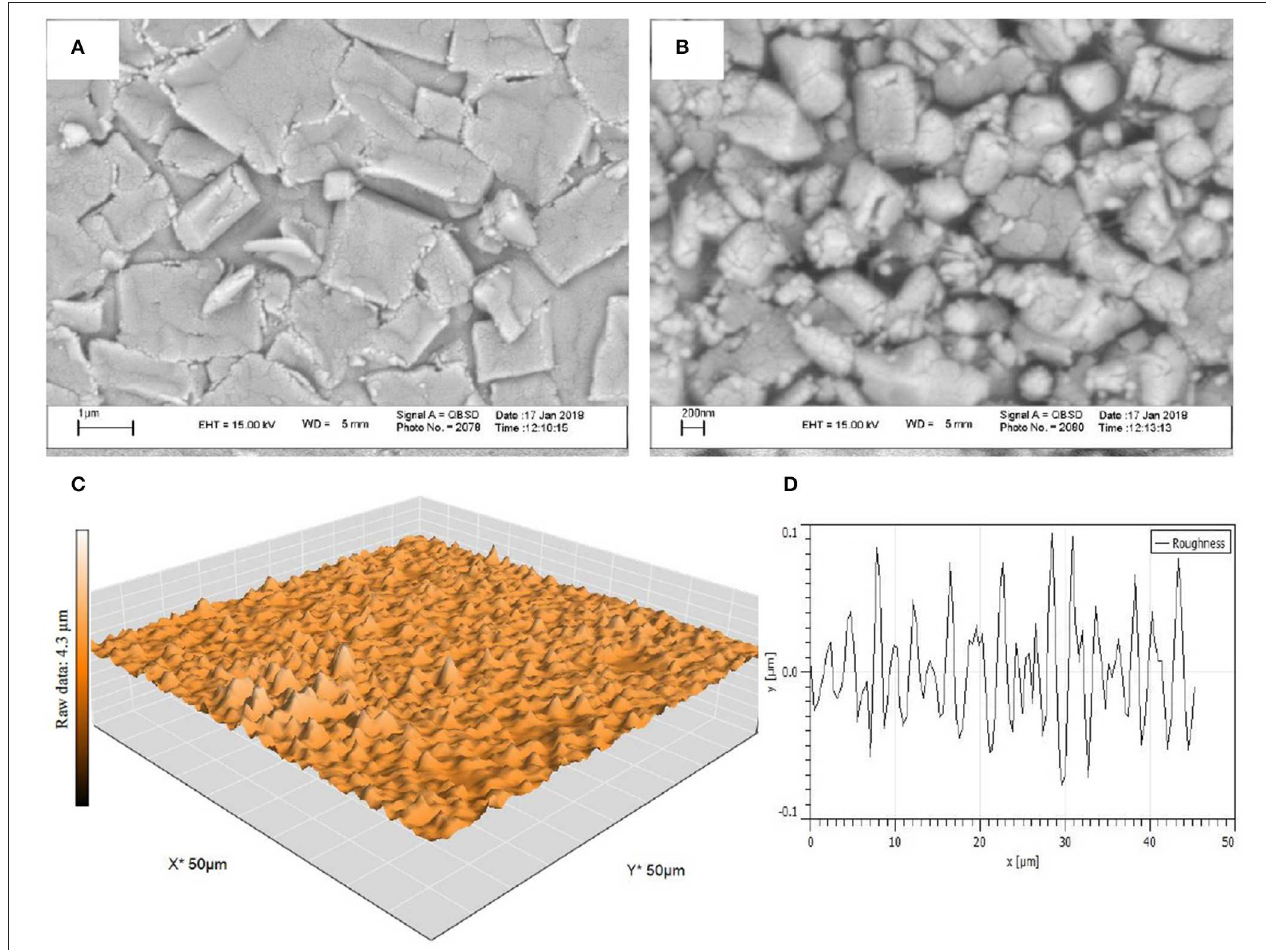
FIGURE 2 | (A,B) SEM micrographs of the MoS 2 nanoflakes with different magnificence. (C) Phase profile of the MoS 2 film and (D) the corresponding height profile as typical.